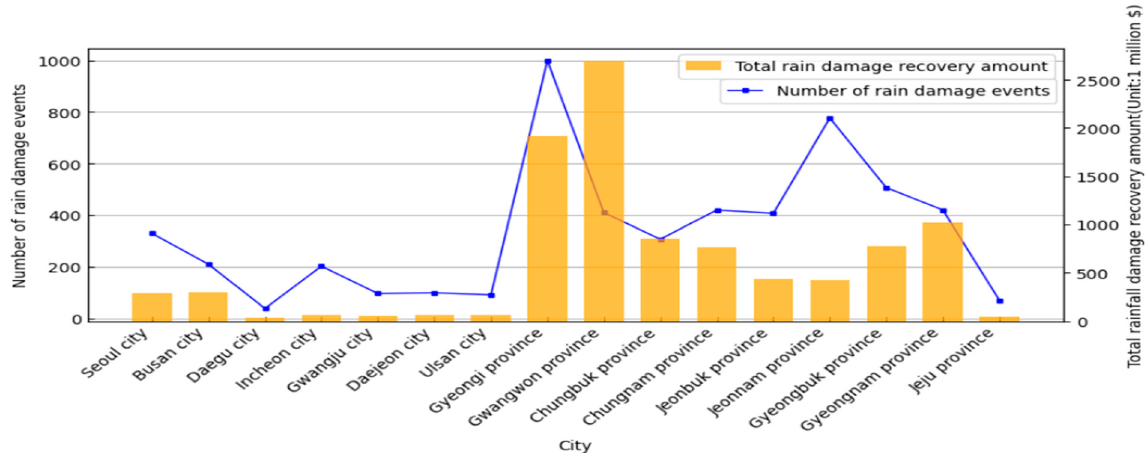
Figure 2. Number of rain damage events and total rain damage recovery amount (1988–2017).